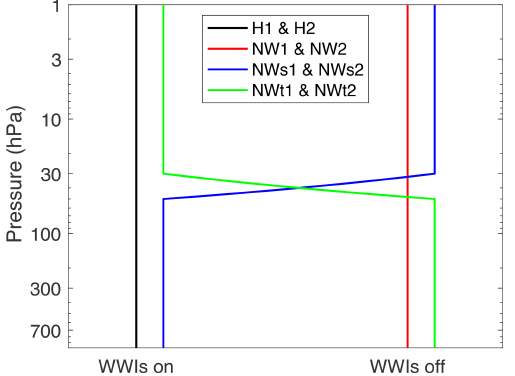
Figure 1. Vertical structure of the four runs used for each wave number (1 or 2). See text for